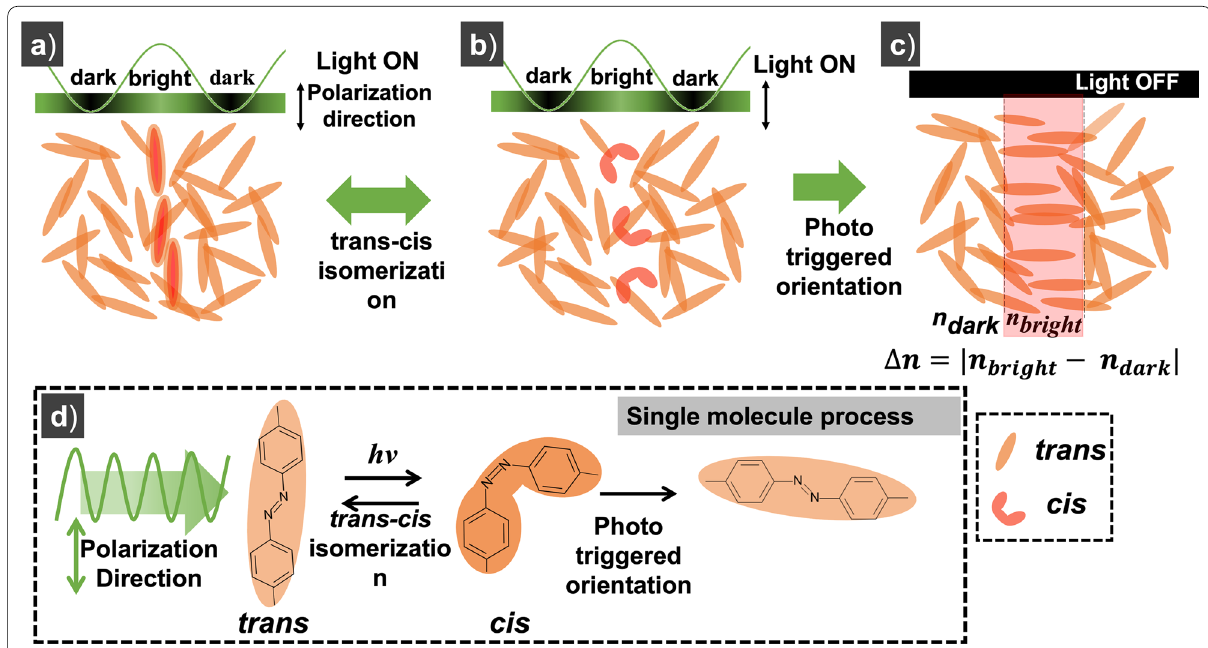
Fig. 2 Schematic showing the process involved in the transfer of light intensity pattern as refractive index modulations ( (cid:31) n ) on the material sample utilizing the phenomena of photoinduced isomerization. a , b Cis-trans isomerization cycle, c phototriggered orientation. d Schematic of the photoinduced isomerization process at a single molecule